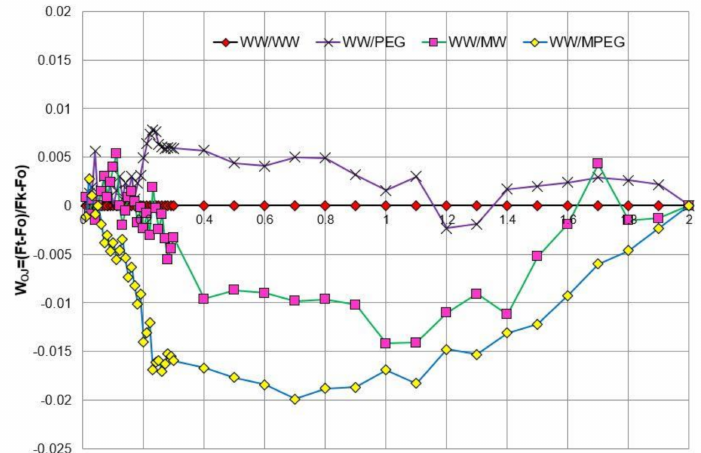
Figure 6. The K-band: Double normalization of the data for the WW, MW, PEG, and MPEG plants under normal and PEG-induced osmotic stress conditions at F 0 and F J , W OJ = (F t –F 0 ) / (F J –F 0 ). The curves represent the di ff erence kinetics, ∆ W OJ of the plants under normal and PEG-induced osmotic stress conditions on a logarithmic